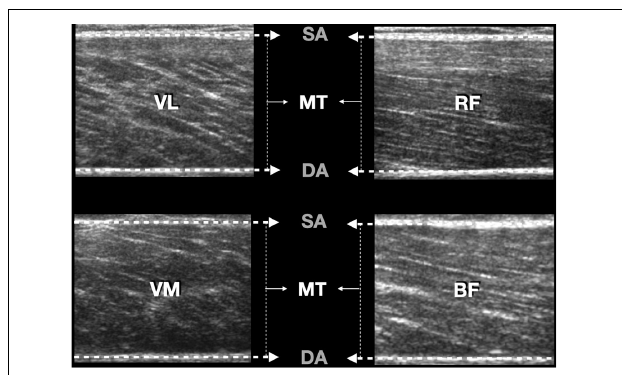
FIGURE 3 | Example of ultrasound image showing the cross-cutting scans of the muscles. SA, superficial aponeurosis; DA, deep aponeurosis; MT, muscle thickness; VL, vastus lateralis; RF, rectus femoris; VM, vastus medialis; BF, biceps femoris.